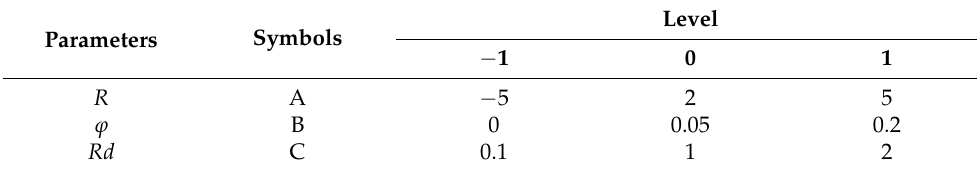
Table 3. Parameters with their levels Nu x ( − 1 ) .